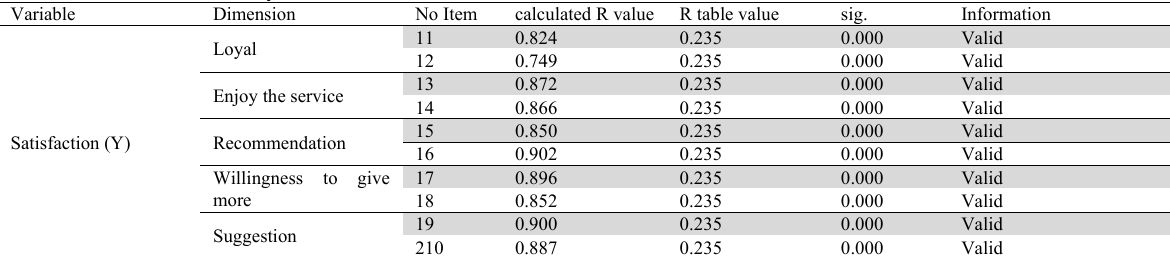
Satisfaction variables validity test results